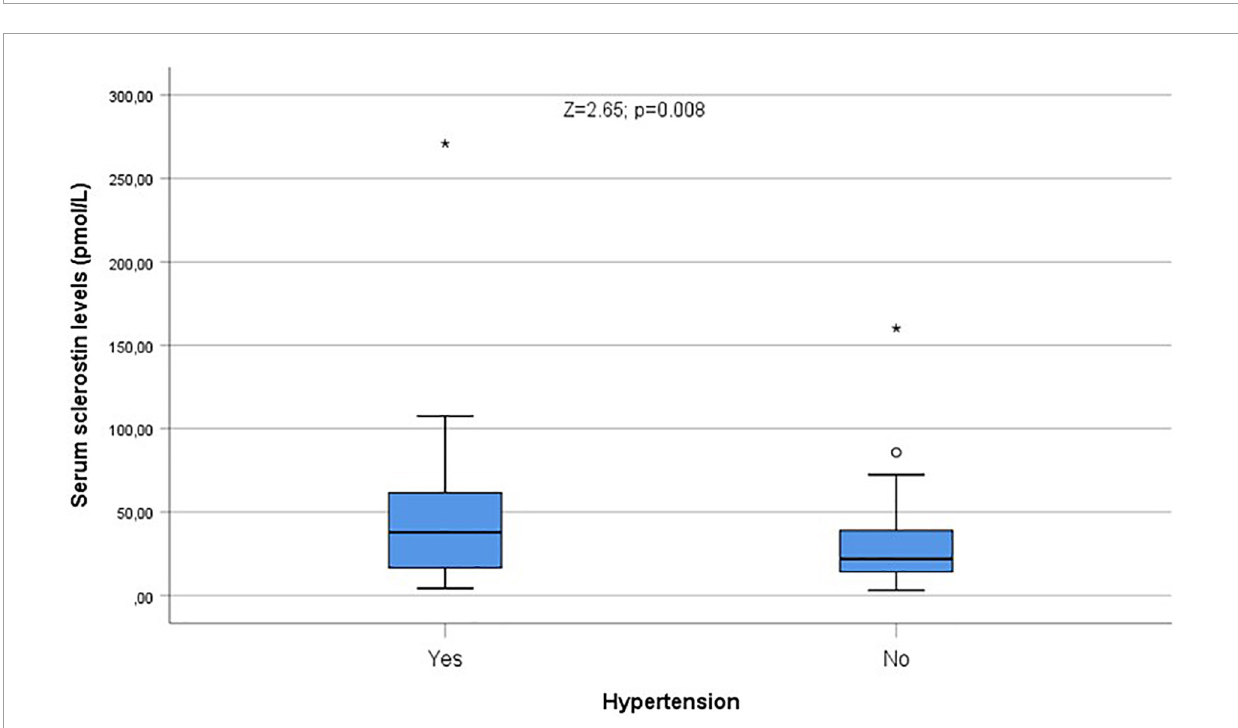
FIGURE3 Serum sclerostin levels were higher in hypertensive patients ( Z = 2.65; p = 0.008). ◦ Represent the outliers and *represent the extreme outliers.